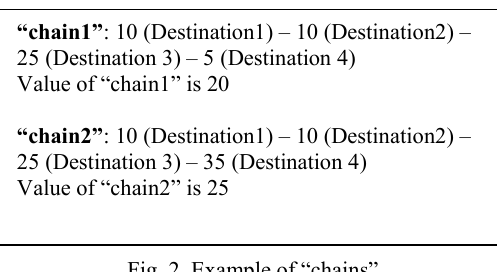
Fig. 1. Example of an overlay network with k -shortest paths for each destination